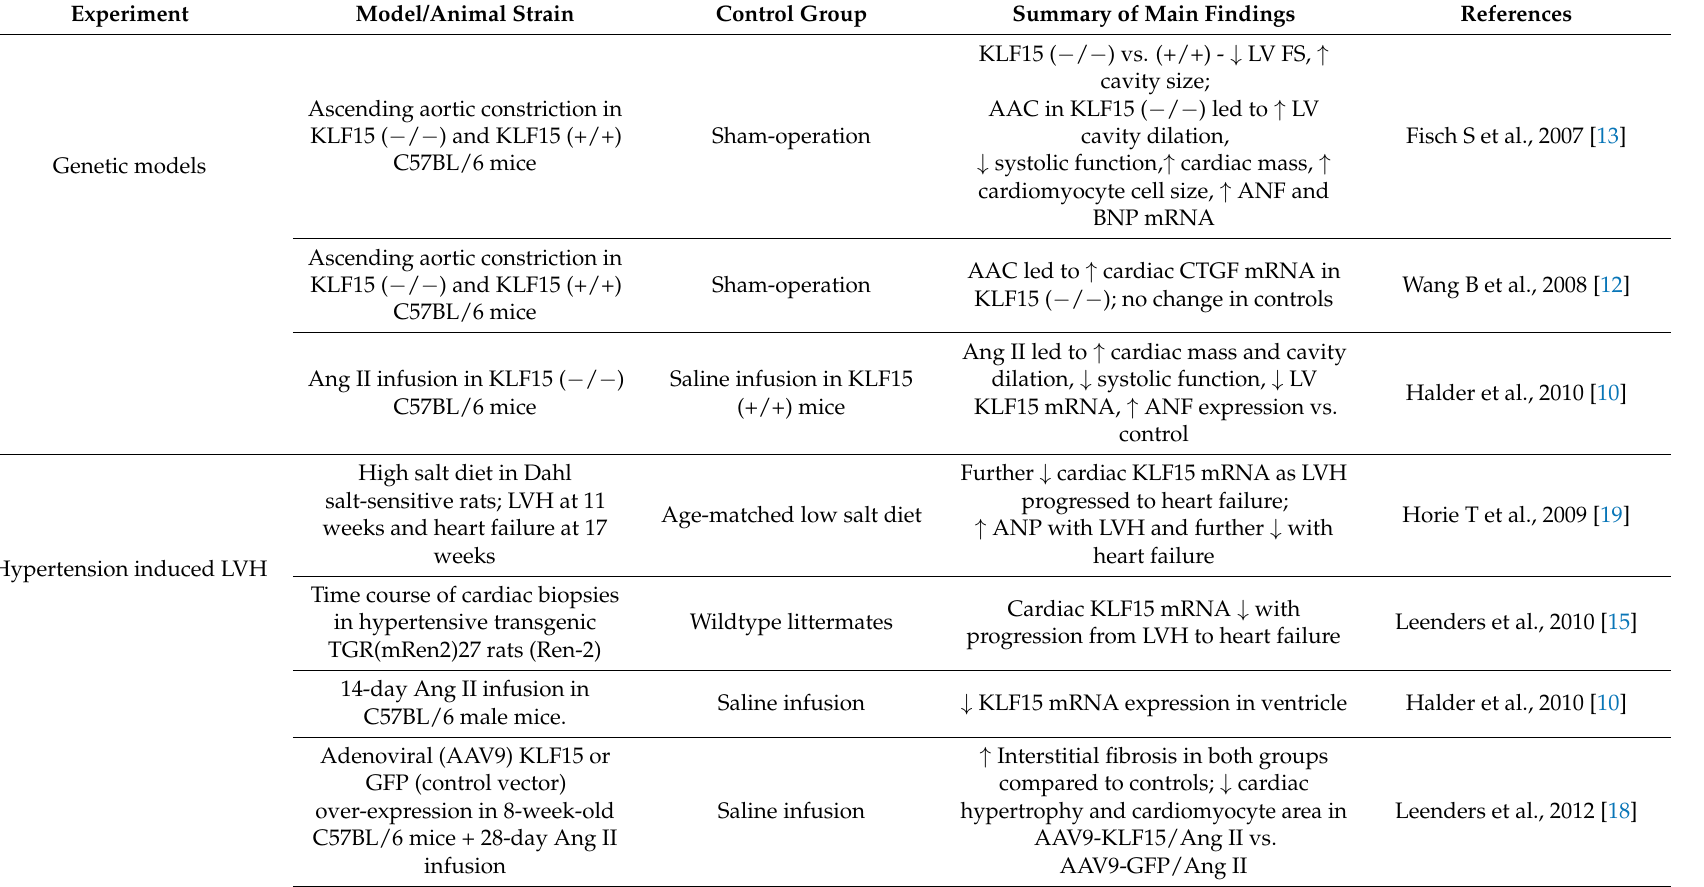
Table 1. In vivo KLF15 experimental